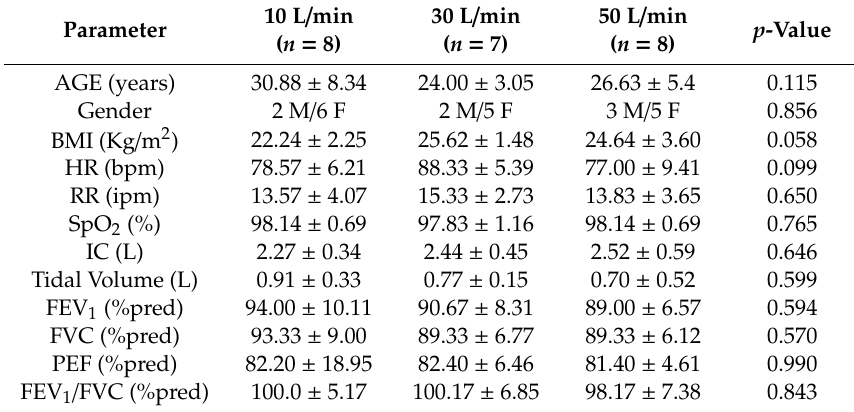
Table 1. Anthropometric characteristics and spirometric measures of participants who received inhalation therapy through HFNC at 10 L / min, 30 L / min, and 50 L / min.